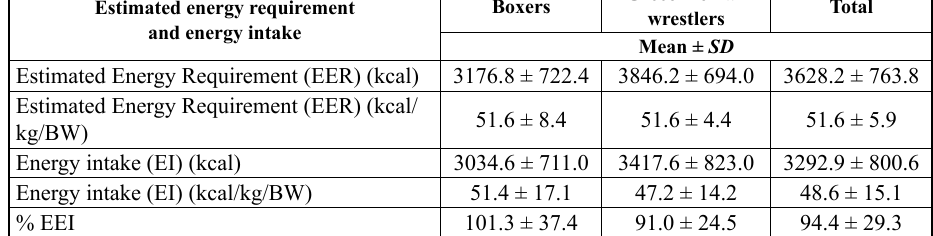
Table 2. Energy intake of combat sports athletes in Lithuania